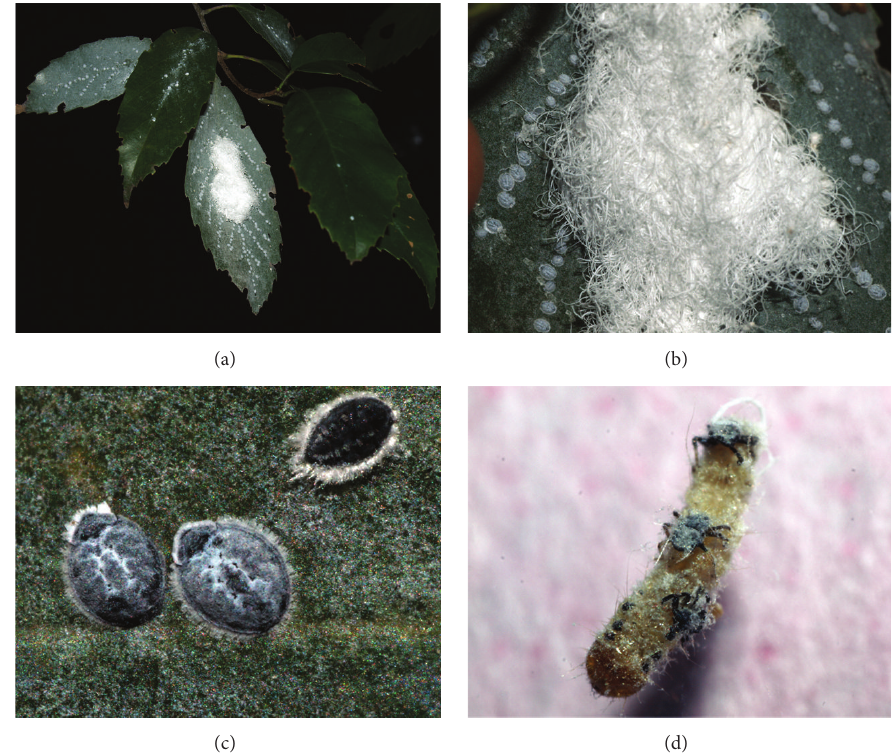
Figure 1: (a) Colonies of Thoracaphis kashifolia on leaves of Quercus glauca (Tama, Tokyo; 14 October 2015); (b) a woolly colony of T. kashifolia (Tama, Tokyo; 14 October 2015); (c) two apterous adults and one nymph to be aptera (upper right) of T. kashifolia (Tama, Tokyo; 8 February 2016); (d) defensive nymphs of T. kashifolia clinging to an experimentally introduced lepidopteran larva (Tama, Tokyo; 1 October 2015).